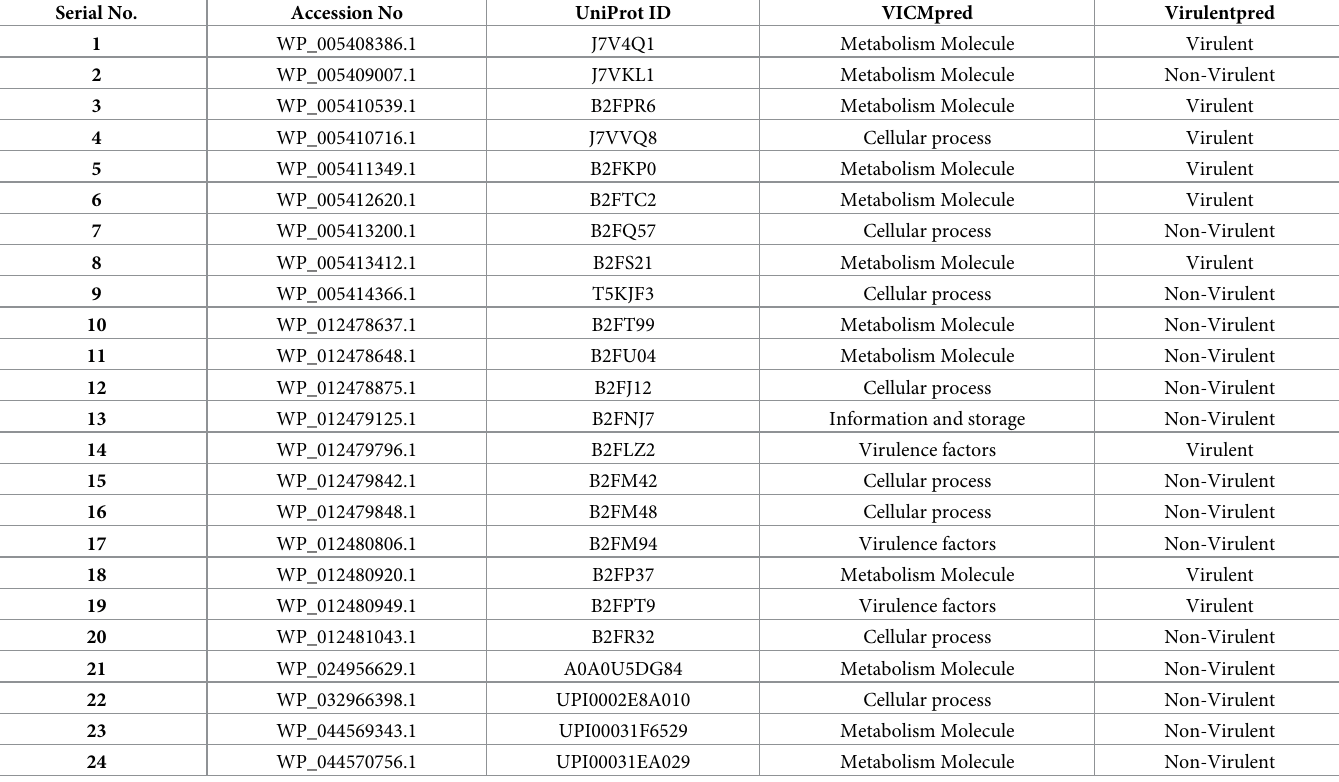
example, the activation of transcription includes multiple transcription factors that work together in gene expression. Moreover, the functions of proteins can be predicted using their PPI information because it is very rare for a protein to interact with different biomolecules. Therefore, PPI databases have become an important resource to study biological networks and pathways [173]. We predicted the PPI and gene co-occurrence for three annotated HCL HPs (highest antigenic protein and two virulent protein), which are thought to be vital players in the pathogenesis of the organism ( Fig 2 ). Gene Co-occurrence network is the graphical visuali- zation of a particular gene network that is possibly present, not necessarily conserved, in a vari- ety of biological organisms. Here in the figure, A1, B1, and C1 are the PPI network of the protein WP_012479796.1, WP_012480949.1, and WP_005413200.1, respectively, while A2, B2, and C2 depicted their corresponding gene co-occurrences. The colored nodes of the PPI net- work represent functionally associated first shell proteins, and each edge shows the type of interactions. Table 3. The virulence factor prediction result of the HPs of S . maltophilia . Serial